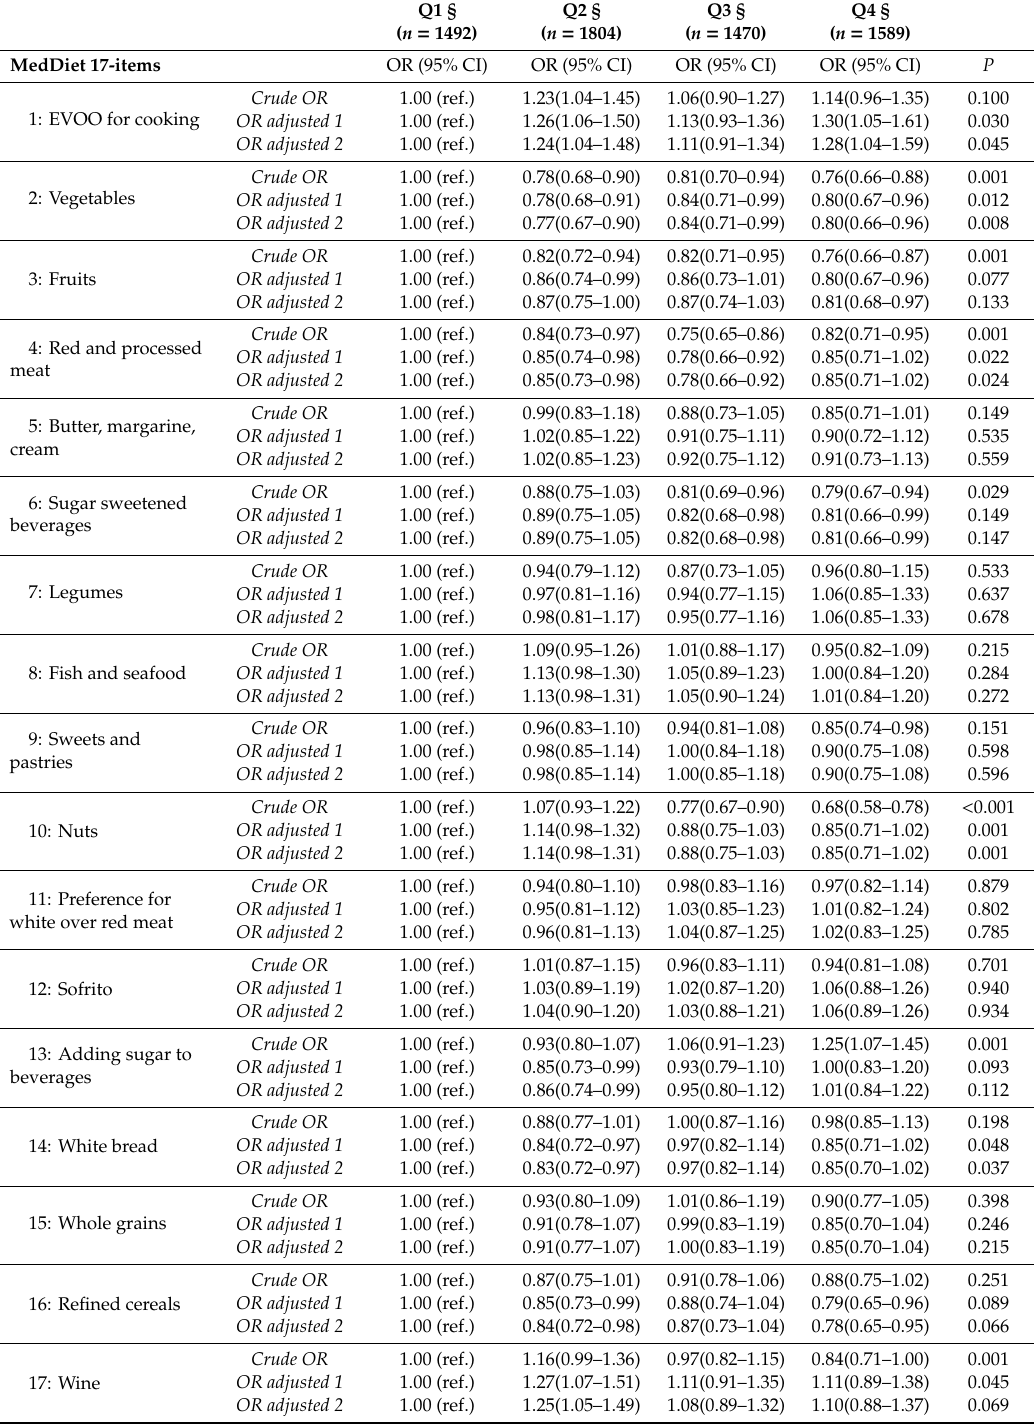
Table 4. Association between the adherence to the Mediterranean Diet 17-items (dependent variables) and the percentage of desired weight loss (independent variables)